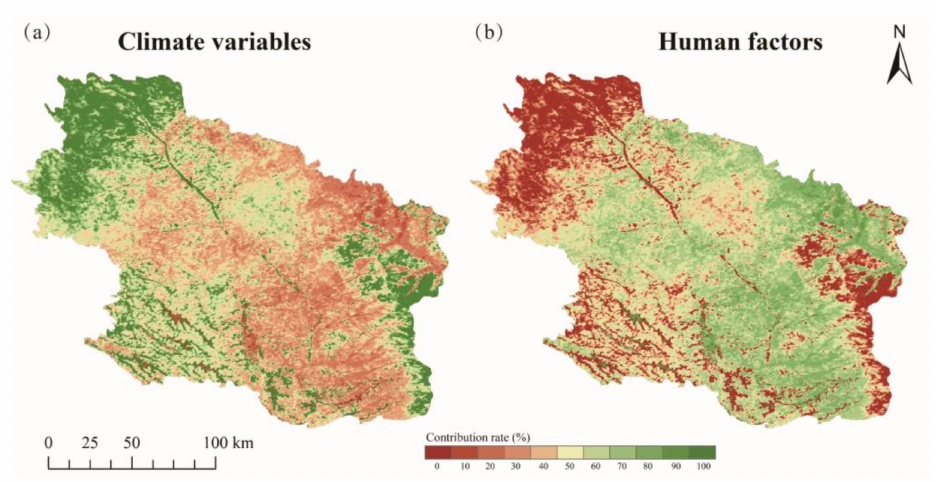
Figure 11. Contribution of ( a ) climate variables and ( b ) human